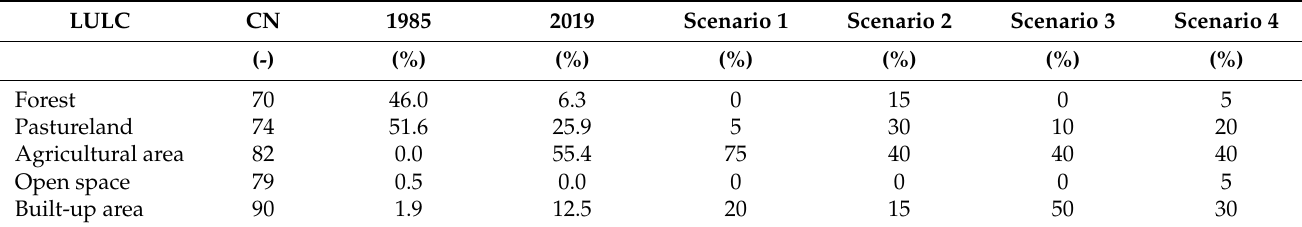
Table 1. LULC, assigned CN, and LULC percentages in different years and projected